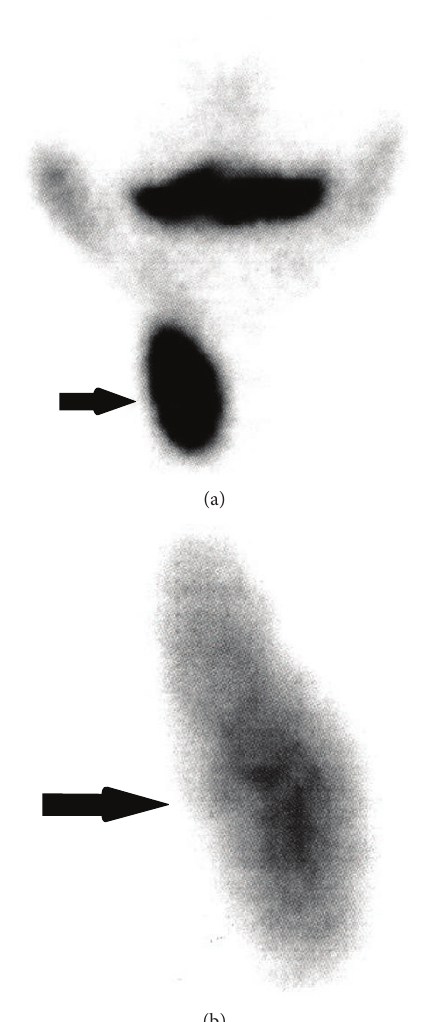
Figure 2: Scintigraphic images of the neck obtained by parallel- hole collimator (a) and pinhole collimator (b). On anteroposterior views, right lobe of the thyroid gland (black arrows) shows minimal hyperplasia with homogeneous uptake. No nodule is demonstrated. At the location of the left lobe of thyroid gland and any other parts of the neck, no accumulation of radioactivity is